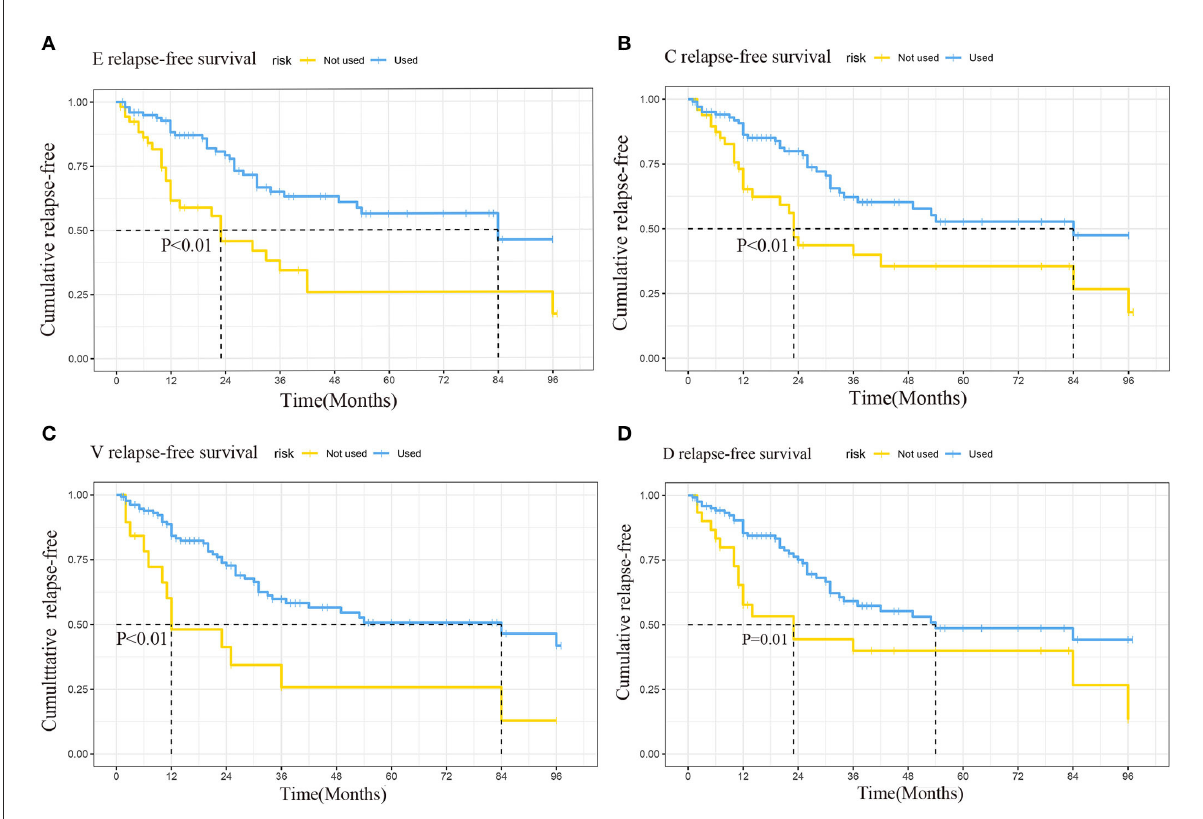
FIGURE7 Relapse-free survival curves of etoposide (A) , cyclophosphamide (B) , vincristine (C) , doxorubicin (D)